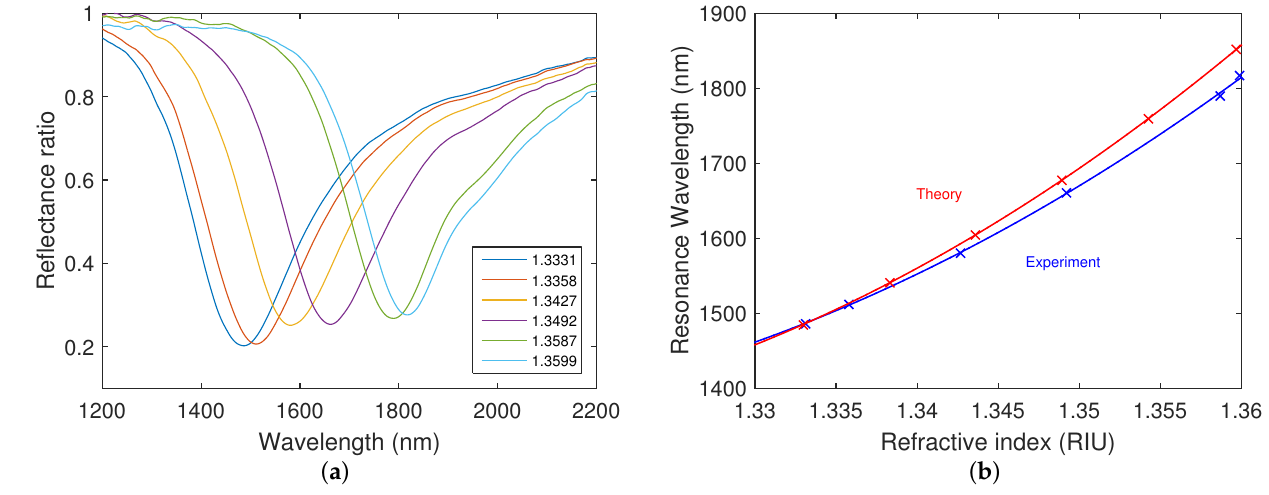
Figure 11. Measured spectral reflectance ratios R p ( λ ) / R ref s ( λ ) ( a ). RI sensitivity measured for a smaller angle of incidence (blue) and theoretical RI sensitivity for angle of incidence θ = 65.6 ◦ = 147.5 nm. (red) ( b ). The silicon dioxide layer thickness t SiO 2